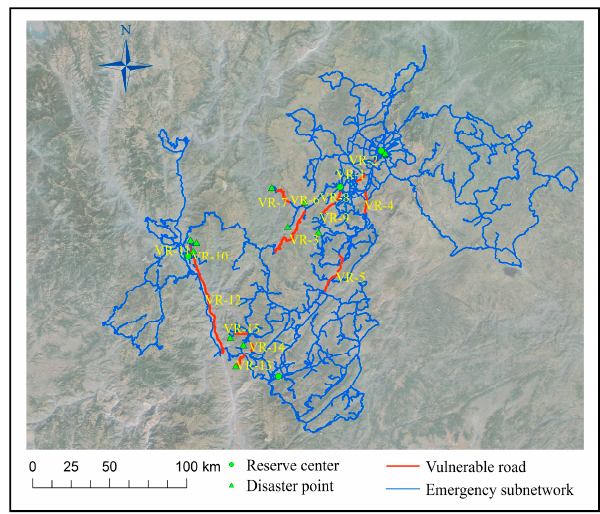
Figure 6. The main vulnerable roads in the emergency network.